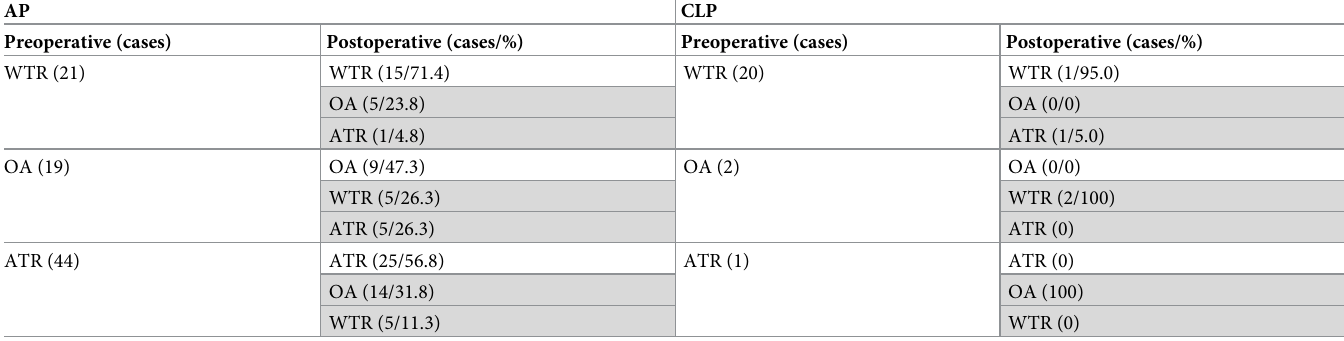
Table 2. Shift in the type of astigmatism postoperatively in the acquired ptosis (AP) and contact lens-related ptosis (CLP) groups. AP